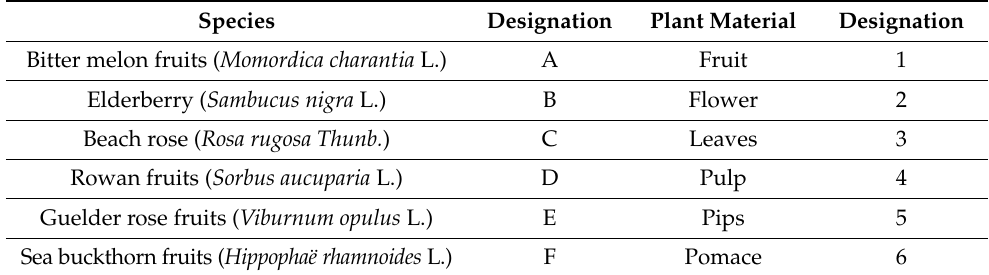
Table 5. Designation of the tested species used in the models. Species Designation Plant Material Designation Bitter melon fruits ( Momordica charantia L.) A Fruit 1 Elderberry ( Sambucus nigra L.) B Flower 2 Beach rose ( Rosa rugosa Thunb. ) C Leaves 3 Rowan fruits ( Sorbus aucuparia L.) D Pulp 4 Guelder rose fruits ( Viburnum opulus L.) E Pips 5 Sea buckthorn fruits ( Hippophaë rhamnoides L.) F Pomace